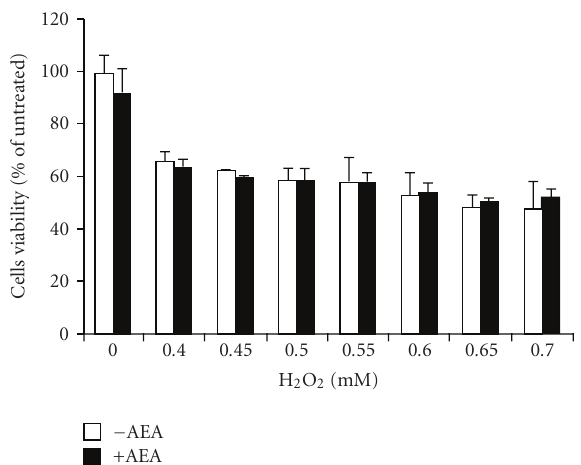
Figure 3: E ff ect of anandamide on H 2 O 2 induced oxidative stress in PC12 cells. Cells were treated with 25 μ M anandamide for 24 hours, followed by treatment with the indicated concentrations of H 2 O 2 for another 24 hours. Cell viability was assessed by the MTT assay. The data shown are average of two separate experiments ±